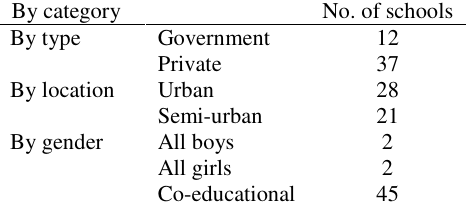
Table 2 Categories of participating schools By category